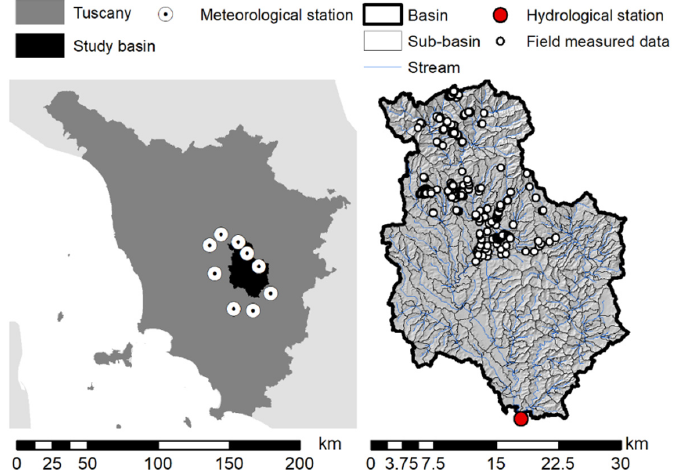
Figure 1. Graphical representation of the study area. Map of Tuscany, in which Arbia stream basin and the position of the meteorological stations are highlighted (Left). The Arbia stream basin with the sub-basin delineation, the position of the hydrometric station and the fields for soil erosion measurement (Right).